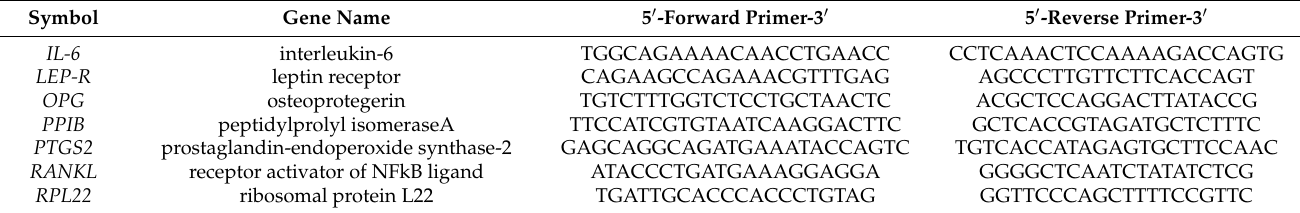
Table 1. Primer sequences for reference genes ( PPIB/RPL22 ) and target